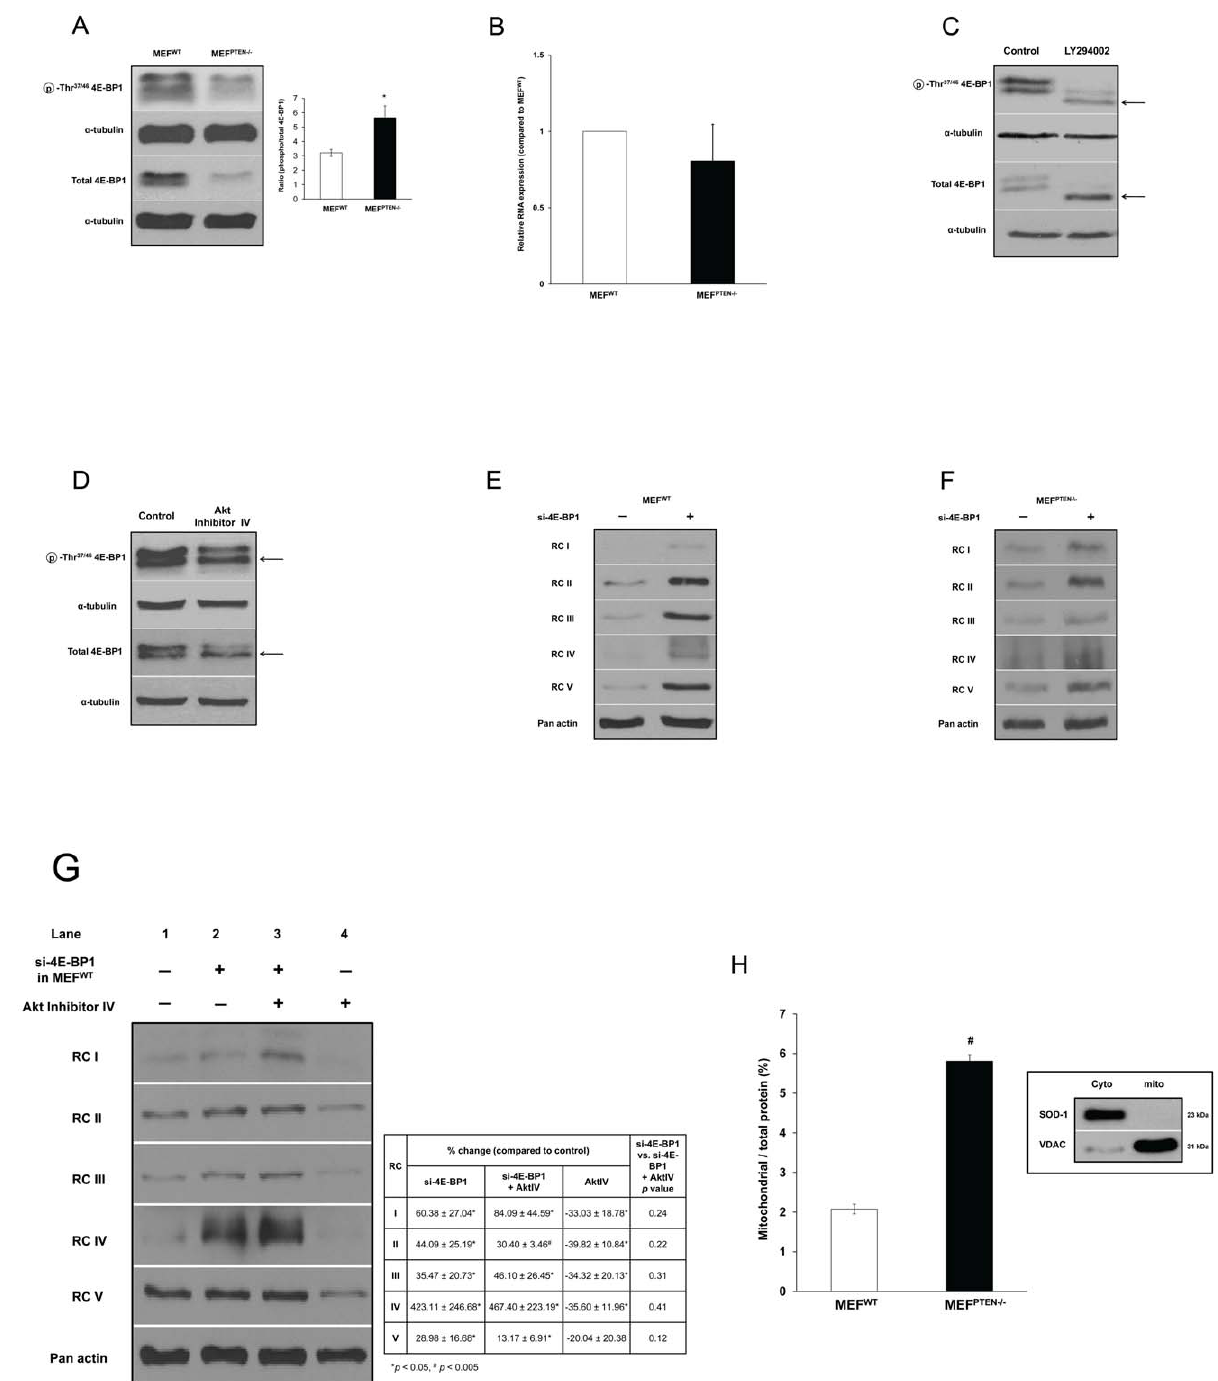
Figure 6. Parameters related to 4E-BP1. ( A ) Protein expressions of 4E-BP1 and p-Thr 37/46 4E-BP1 MEF PTEN 2 / 2 has significantly lower total 4E-BP1 but a higher ratio of phospho- relative to total- 4E-BP1 (inset). * p , 0.05 for n=3. ( B ) mRNA Level of 4E-BP1 The mRNA of 4E-BP1 was not different between MEF WT and MEF PTEN 2 / 2 with p =0.231 for n=3. ( C ) Effect of LY 294002 Hypo-phosphorylation of 4E-BP1 and p-Thr 37/46 4E-BP1 by LY was observed by downward band shifts in both, as indicated by arrows. ( D ) Effect of Akt inhibitor IV Hypo-phosphorylation of p-Thr 37/46 4E-BP1 and total 4E-BP1 by Akt inhibitor IV (shown as bands of higher density, indicated by arrows) was observed but no band shift was evident. ( E, F ) RNA-silencing of 4E-BP1 on protein expressions of RCs in MEF WT and MEF PTEN 2 / 2 Up-regulation of the expressions of all RCs was apparent. However, the effect was more pronounced in MEF WT because of its higher expression of 4E-BP1 as shown in Fig. 6A. The fact that RC up-regulation was also observed in MEF PTEN 2 / 2 suggested that there was residual 4E-BP1 in the knockout which was indeed shown in Fig. 6A. ( G ) Gene silencing of 4E-BP1 with and without Akt Inhibitor IV on RC expressions in MEF WT RC expressions were significantly higher with si-4E-BP1 compared with untreated control (Lane 1) in MEF WT in the absence or presence of Akt inhibitor IV as shown in Lanes 2 and 3, respectively (*p , 0.05, # p , 0.005 relative to untreated controls). Thus, it was evident that in the absence of 4E-BP1, Akt did not affect RC expressions significantly with p values . 0.05 (Fig. 6G inset, comparing Lanes 2 and 3). In contrast, in the presence of an Akt inhibitor (AktIV), RC expressions were down-regulated when 4E-BP1 was intact (Lane 4) showing that the action of